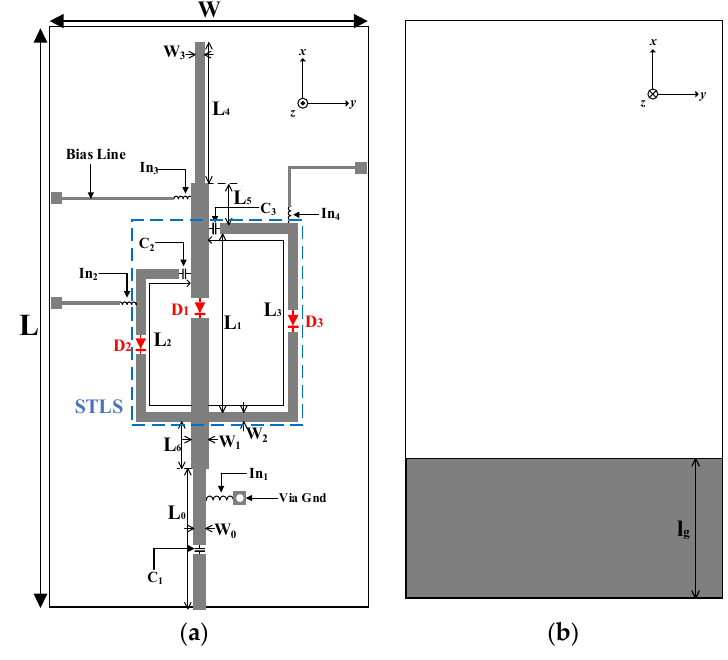
Figure 1. Geometry of the proposed antenna: ( a ) top and ( b ) back view.